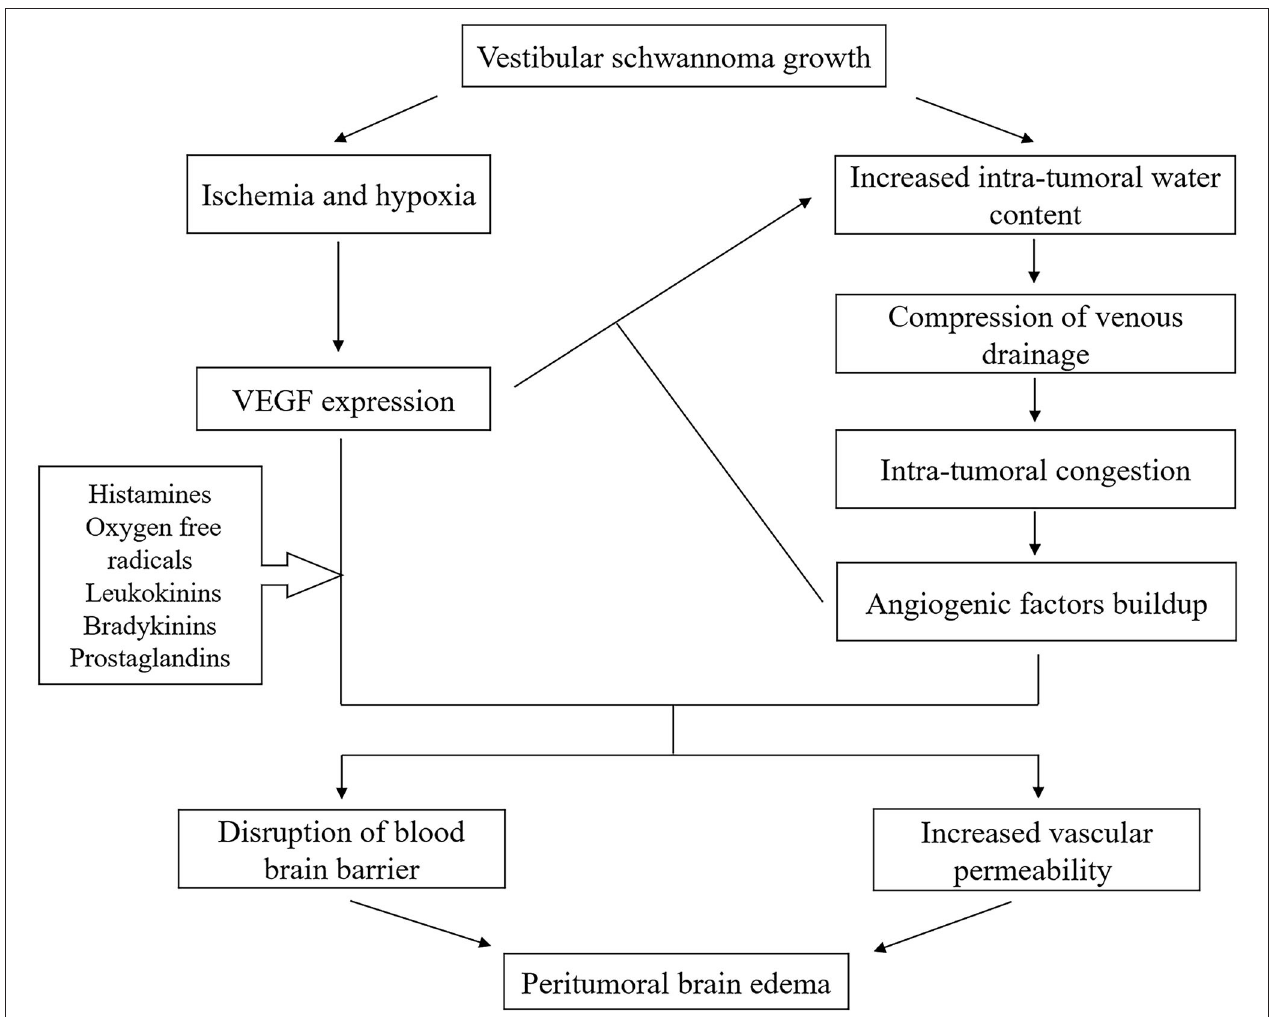
FIGURE 5 | Proposed mechanisms of PTBE formation in VS. PTBE, peritumoral brain edema; VS, vestibular